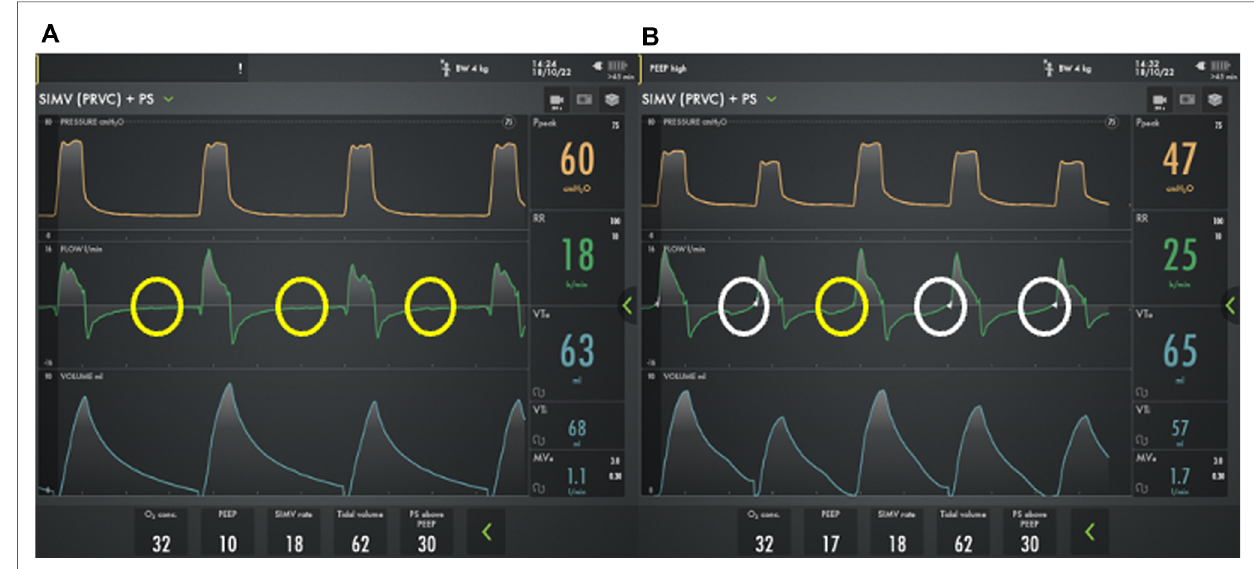
FIGURE 4 Ventilator waveforms from a 2 month old former 24 week premature infant with severe bronchopulmonary dysplasia using two different PEEP strategies. On physical exam, the child has a respiratory rate of 26 breaths/min. A ) However, using a PEEP 10 cm H 2 O, he has multiple failed triggers (yellow circles) and does not appear to breathe above the mandated rate. B ) By increasing the PEEP to 17 cm H 2 O there is improved synchronization with the ability to trigger his spontaneous breaths, though the trigger is delayed (white circles) and one patient effort fails to trigger a breath (yellow